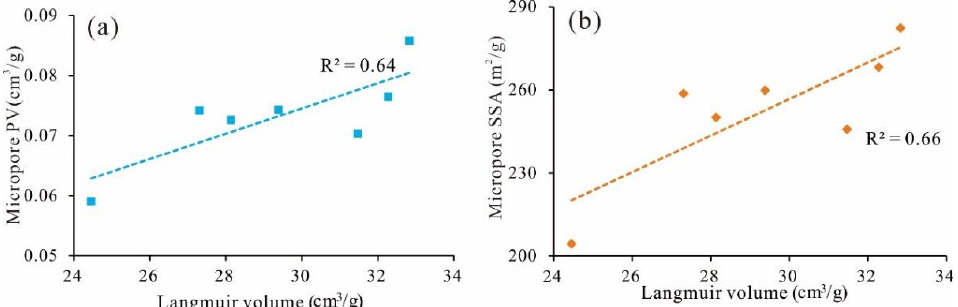
Figure 15. Relationships between the high-pressure CH 4 adsorption capacities and ( a ) micro-PV and ( b ) micro-SSA.